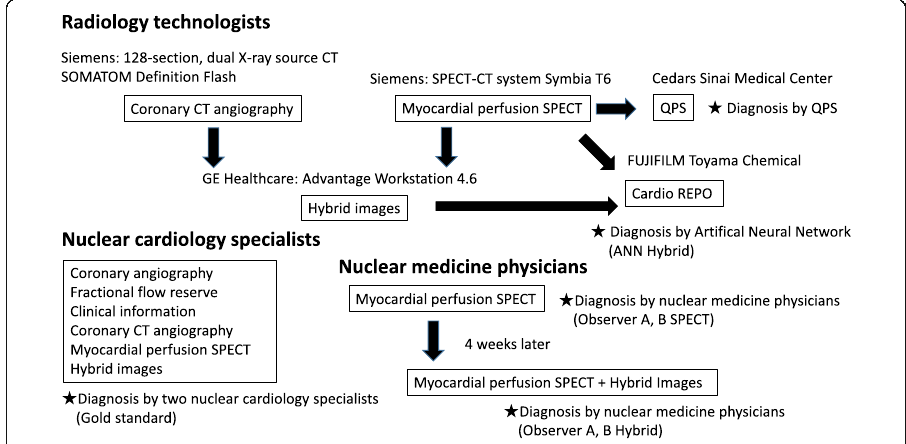
Fig. 1 Basic flow chart of roles of radiology technologists, nuclear medicine physicians, and interpretation. ANN artificial neural network, CT computed tomography, QPS quantitative perfusion single-photon emission computed tomography, SPECT single-photon emission computed